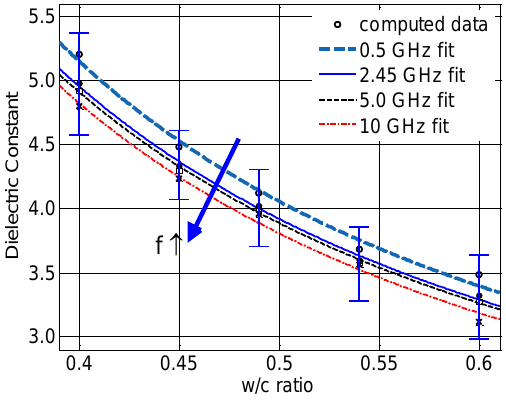
Figure 7. Dielectric constant versus water-to-cement ratio of GB concrete. Table 8. Regression coefficients (with 95% confidence bounds) and goodness-of-fits for Equation